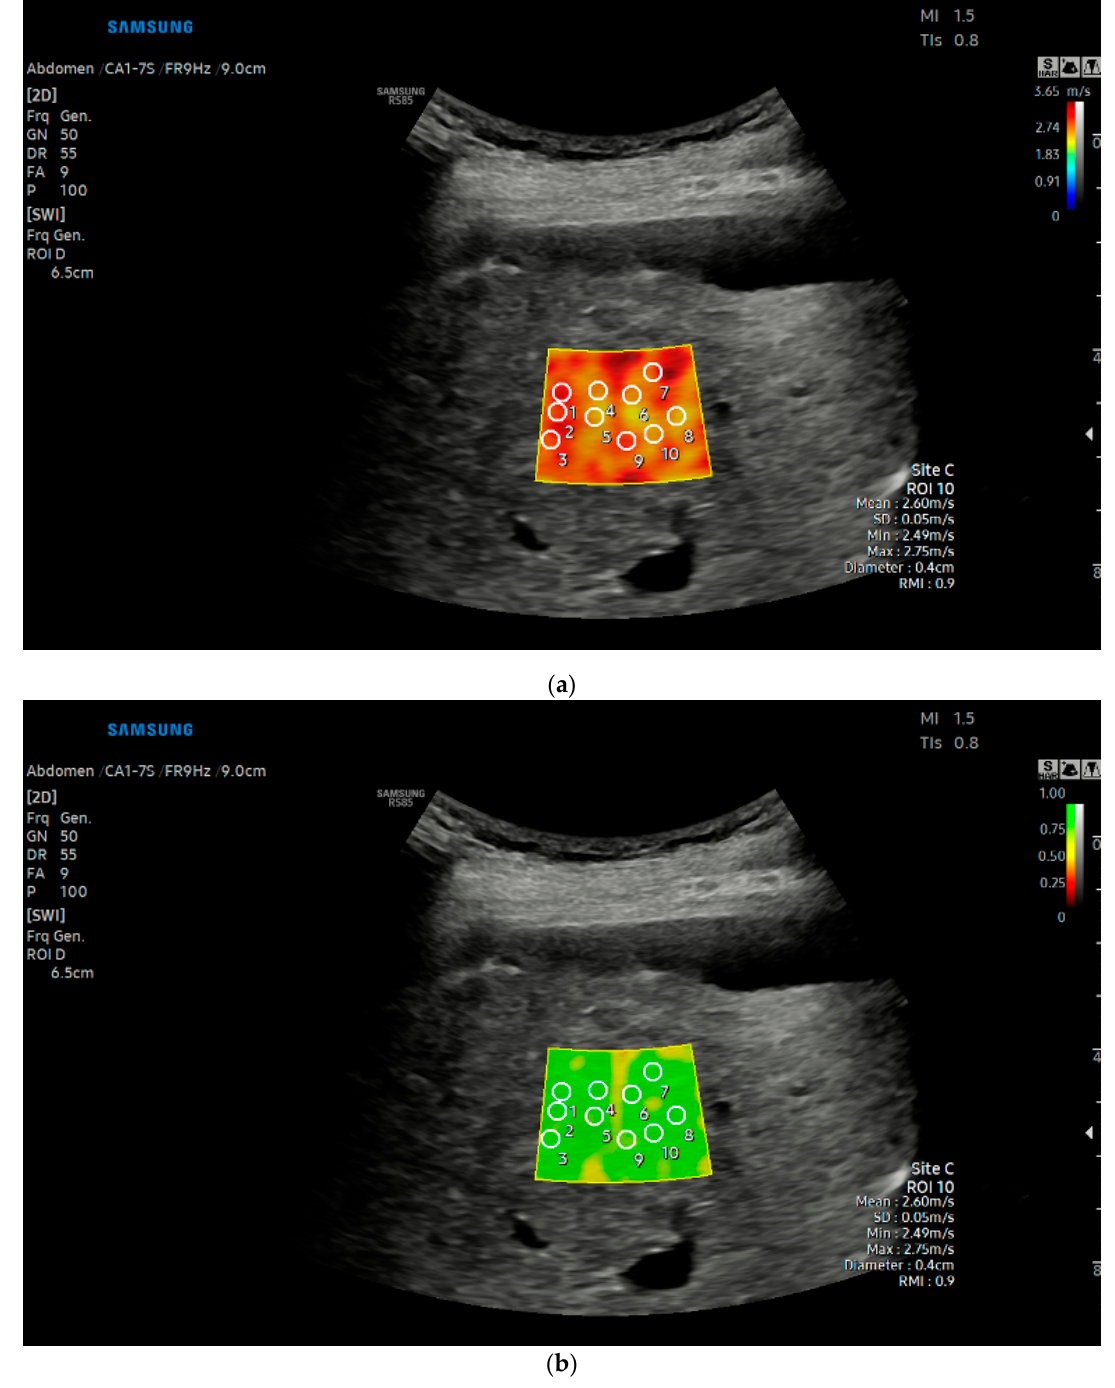
Figure 1. Liver stiffness (LS) measurement with 2D shear wave elastography (SWE). ( a ) LS measurement of a cirrhotic patient. The LS was reported in m/s units. ( b ) Color-coded map of the reliable measure index (RMI) values of SWE measurement was used for ROI selection in the cirrhotic liver parenchyma. Only measurements with an RMI ≥ 0.4 were considered acceptable.